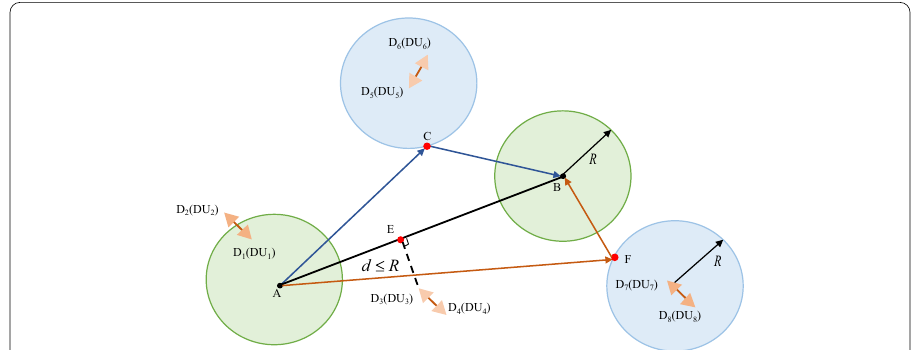
Fig. 2 Illustration of DU distribution and UAV trajectory. Both A and B are stop points, and triangles represent D2D